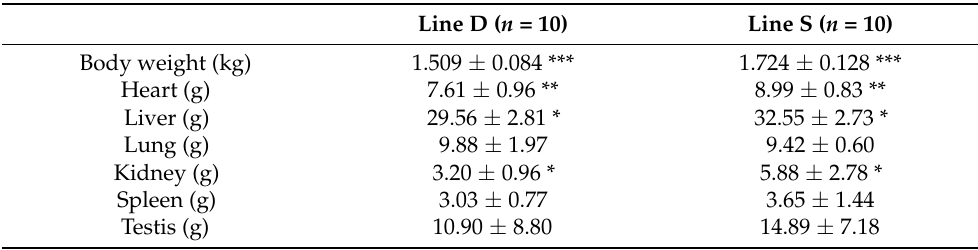
Table 1. Body and organ weights of line D and line S at